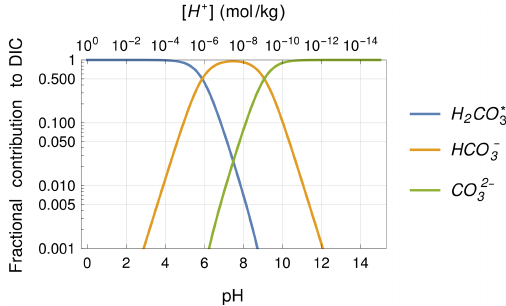
Figure 2. Carbon species fractional contribution to DIC for varying